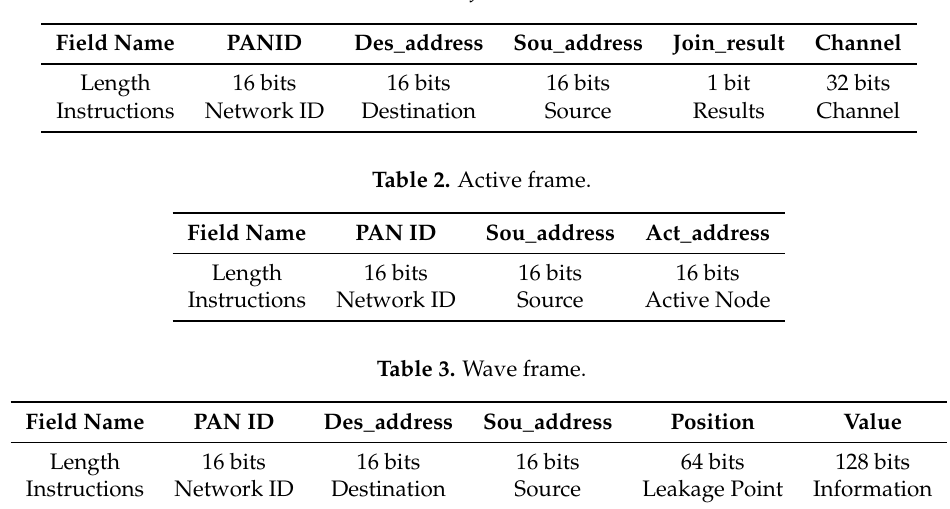
Table 1. Join frame.